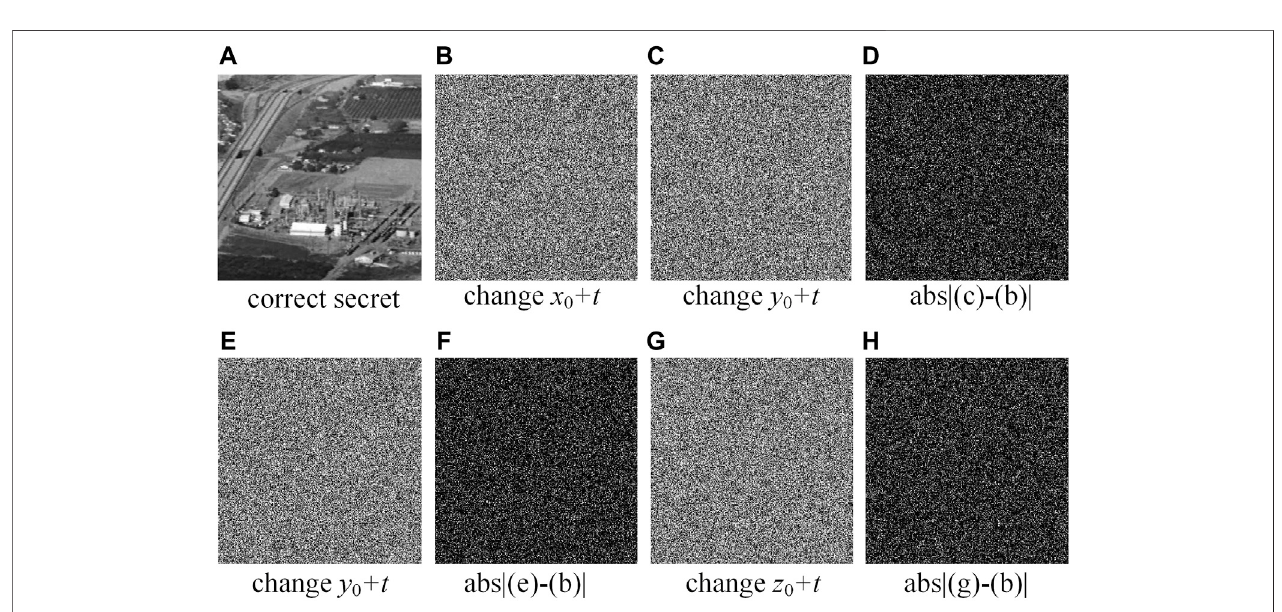
FIGURE 6 | Key sensitivity test in the deciphering stage